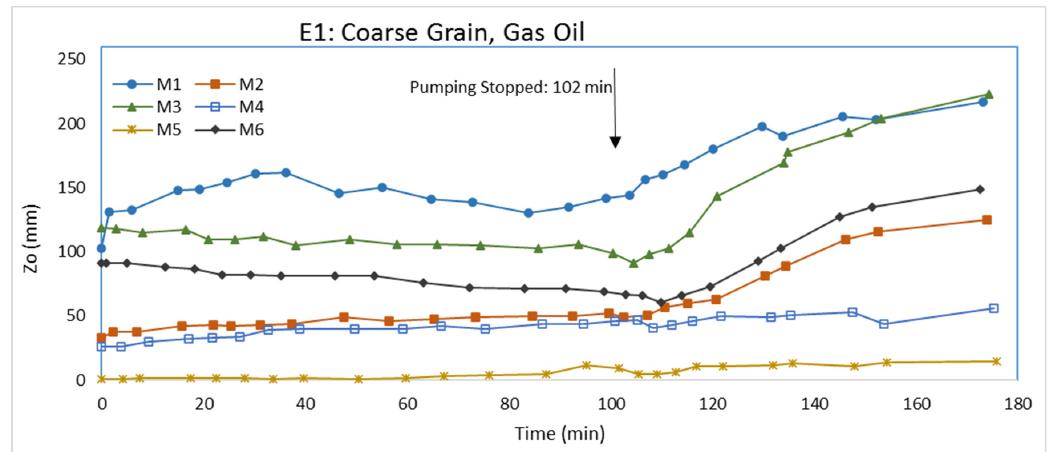
Figure 3. LNAPL thickness (Zo) variations in monitoring wells for E1.